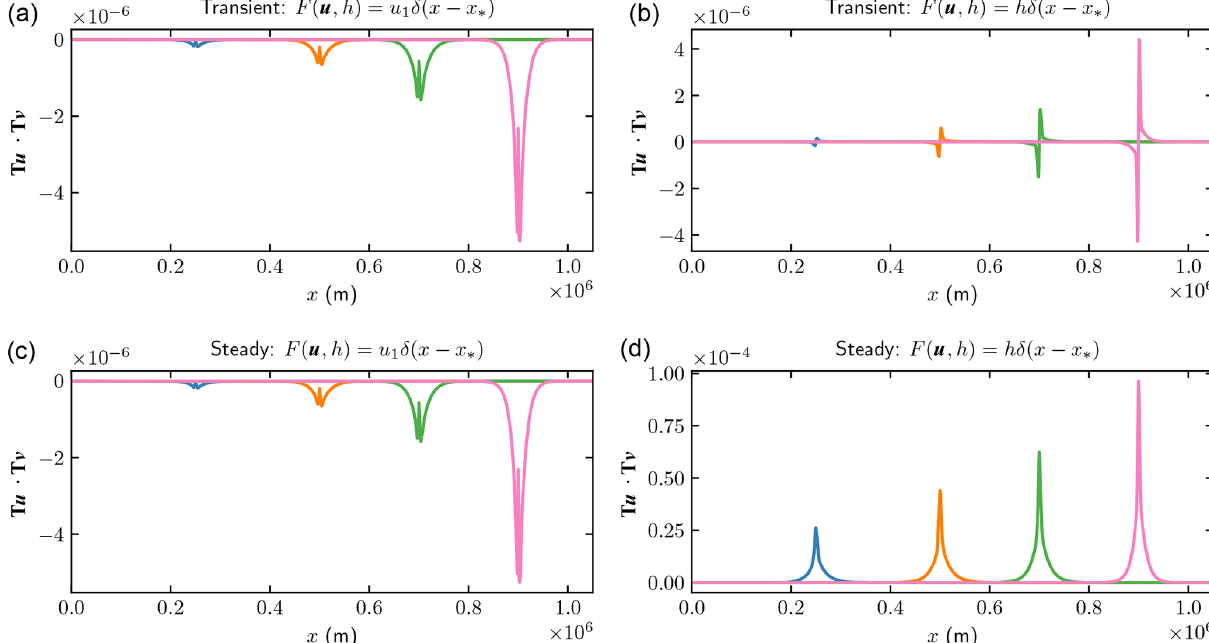
Figure 2. Comparison of the weights T u · T v in Eq. (10) for perturbations δC at different observation points x ∗ = 0 . 25 × 10 6 , 0 . 5 × 10 6 , 0 . 7 × 10 6 , and 0 . 9 × 10 6 (blue, orange, green, and pink). (a, b) Transient simulations; (c, d) steady states. (a, c) w uC with pointwise u response; (b, d) w hC with pointwise h